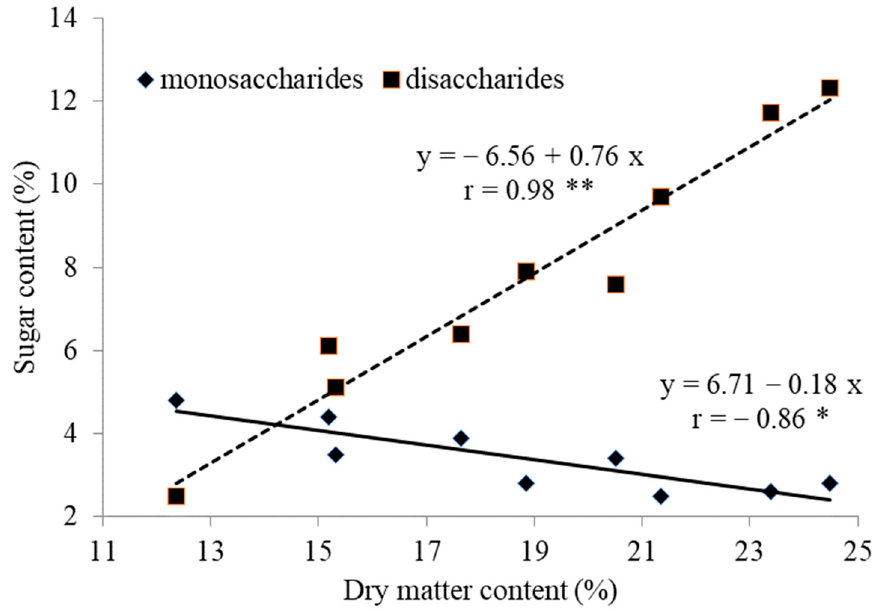
Figure 1. Correlations between dry matter and sugar content in leek pseudo-stems.